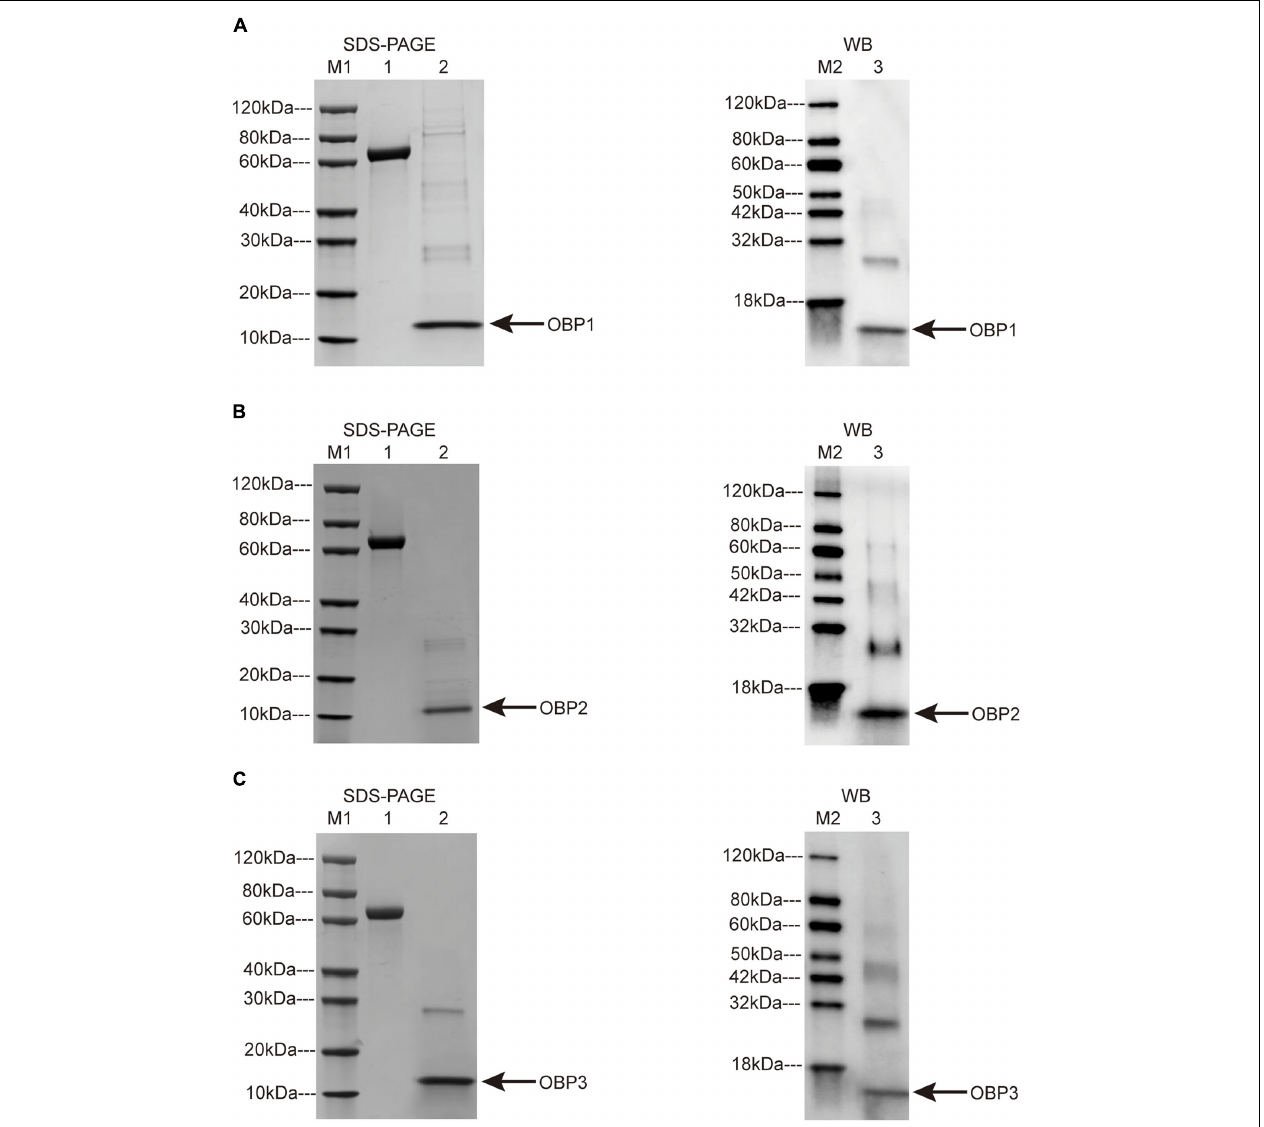
FIGURE 4 | SDS-PAGE (left) and Western blot (right) analysis of Trissolcus japonicus OBP1 (A) , T. japonicus OBP2 (B) , and T. japonicus OBP3 (C) . M1: Protein Marker 1; M2: Protein Marker 2; 1: BSA, 2.0 µ g; 2: SDS-PAGE OBPs; 3: Western blot OBPs. Arrows indicate the protein